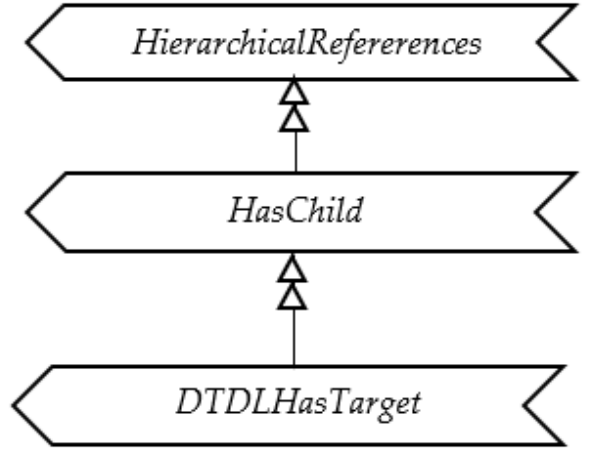
Figure 9. OPC UA DTDLHasTarget Reference.